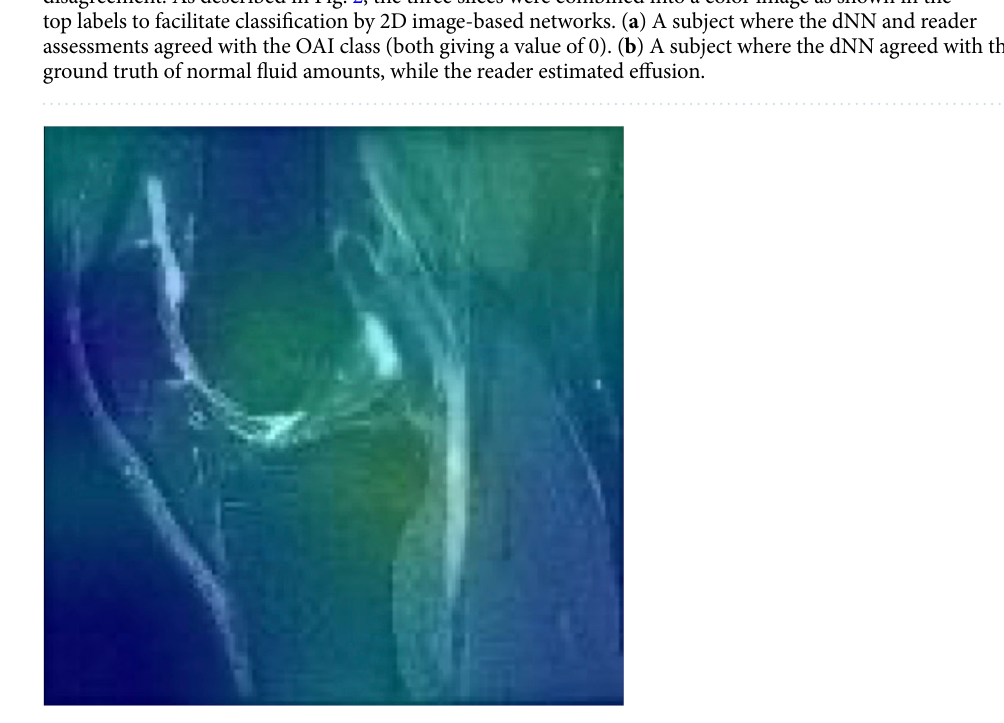
Figure 7. Sample occlusion map, demonstrating regions of high sensitivity for